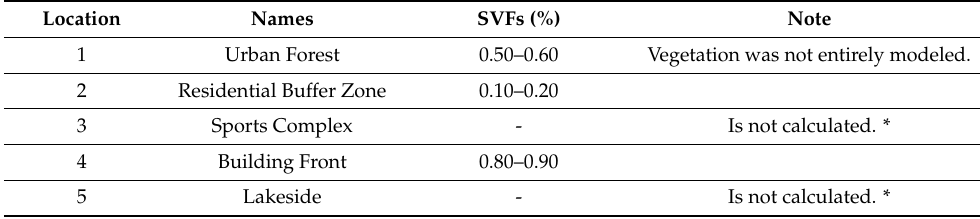
Table 2. Sky view factor values from ENVI-met 3D models.